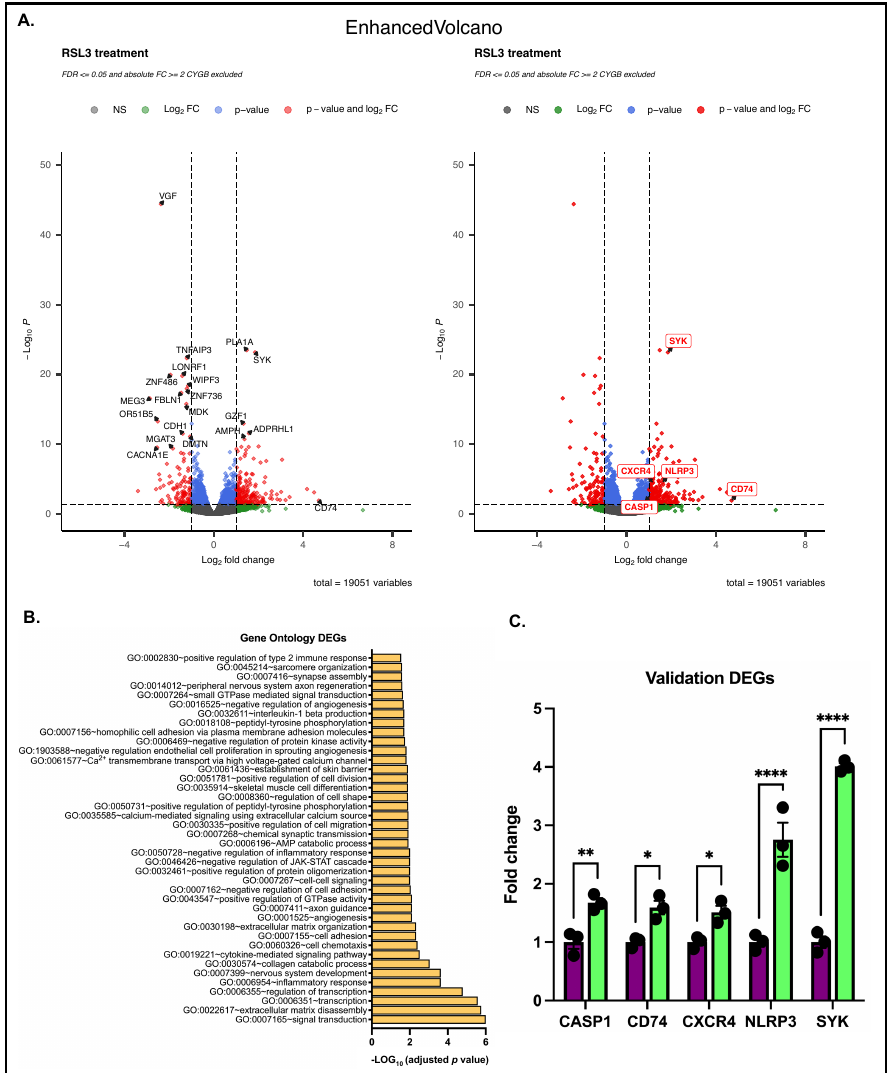
Figure 7. CYGB-dependent differences in response to RSL3 treatment. Comparison of RSL3-treated G361-shCTR and G361-shCYGB cells. ( A ) Enhanced volcano plots of the differential expression analysis (DESeq2) of RSL3-treated G361-shCTR versus G361-shCYGB cells. Differentially expressed genes were represented based on their Log 2 fold change (Log 2 FC) and − Log 10 p -adjusted value ( − Log 10 P ). ( B ) The top-ranked gene ontology (GO) terms of the differentially expressed genes (DEGs) identified upon GO enrichment analysis. ( C ) Validation of selected DEGs by RT-PCR. Fold change represents the average fold change expression in G361-shCYGB cells compared to G361-shCTR cells (set as 1). Results are depicted as the mean with S.E.M. of three independent experiments ( n = 3). One-way ANOVA (* p ≤ 0.05; ** p ≤ 0.01; **** p ≤